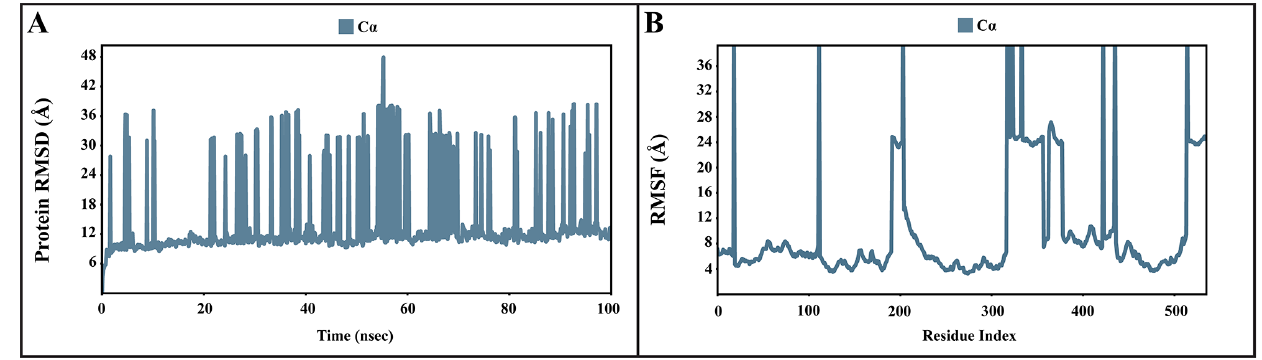
Figure 7. The P-RMSD and P-RMSF of the apo-AcSIR2 protein. ( A ) Plot of the P-RMSD of the apo-AcSIR2 protein. ( B ) Plot of the P-RMSF of the apo-AcSIR2 protein. P-RMSD, protein root mean square deviation; P-RMSF, protein root mean square fluctuation; AcSIR2, A. castellanii Sir2 family